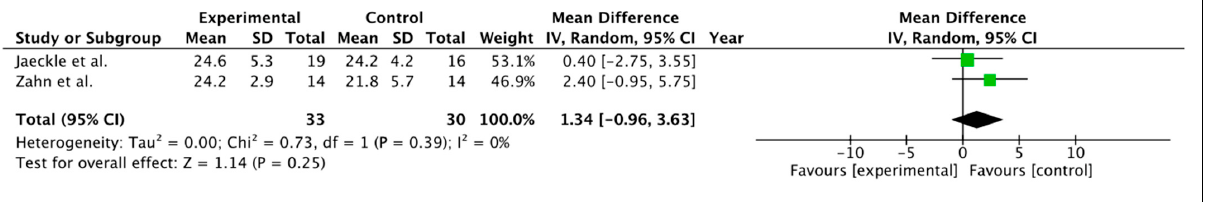
Figure 6. Forest plot. Increases self-esteem on the Rosenberg global self-esteem scale from baseline